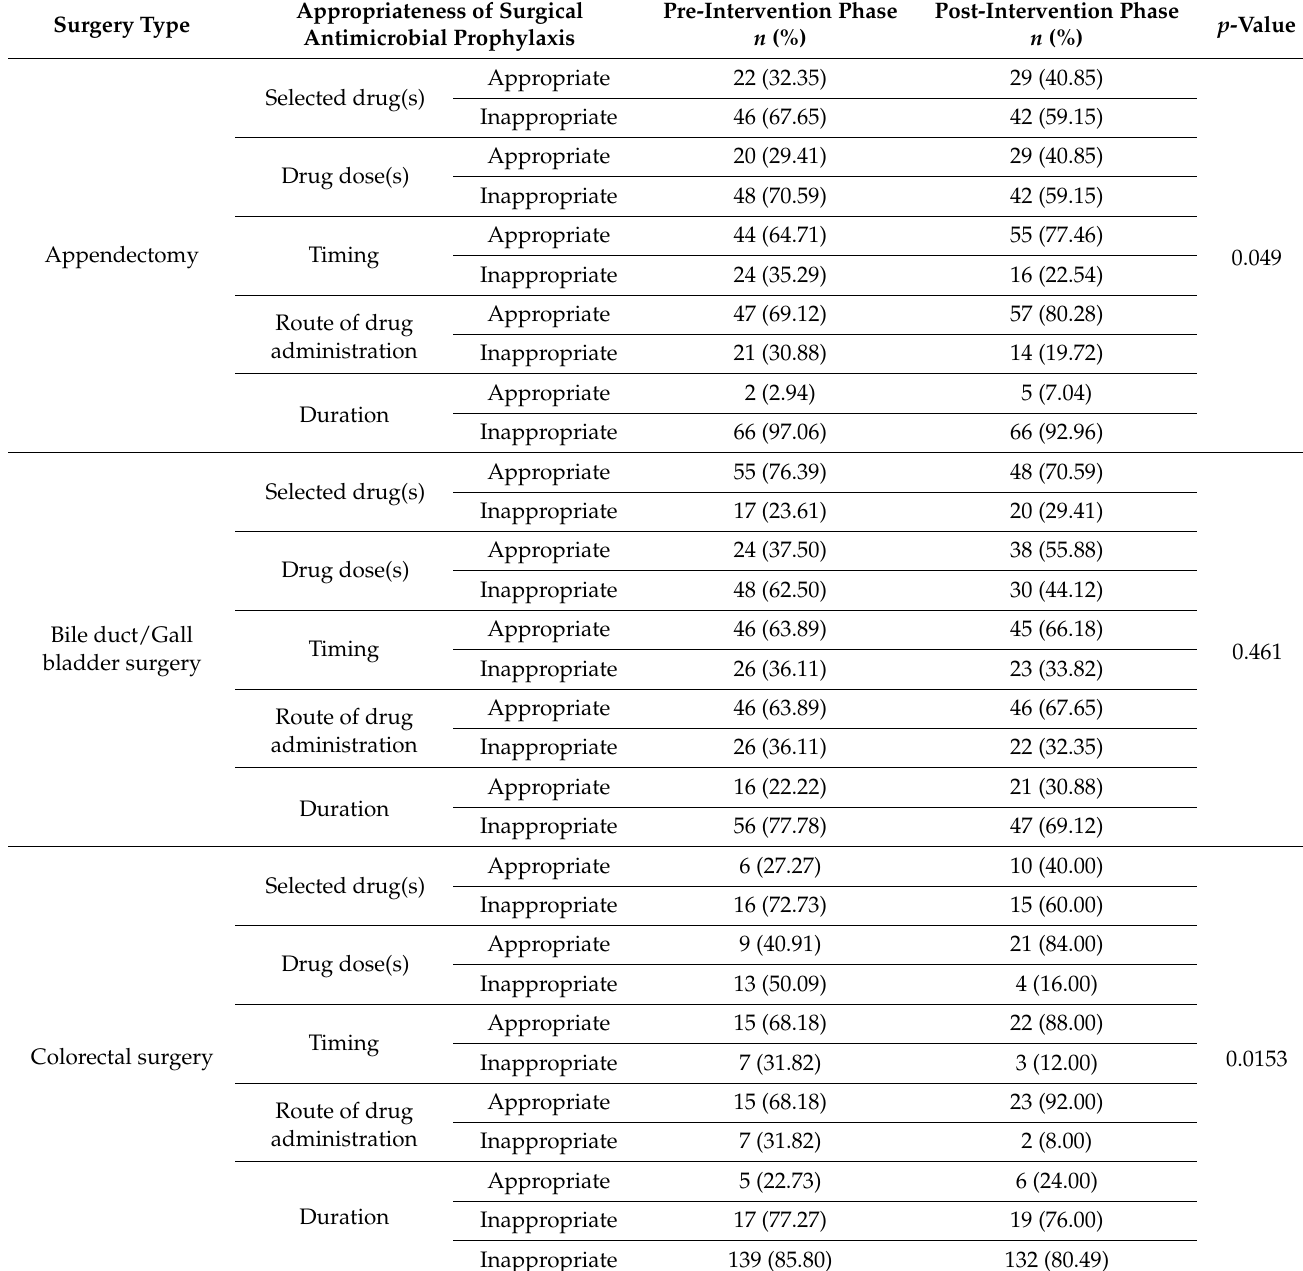
Table 4. Appropriateness of surgical antimicrobial prophylaxis in the pre- and post-intervention